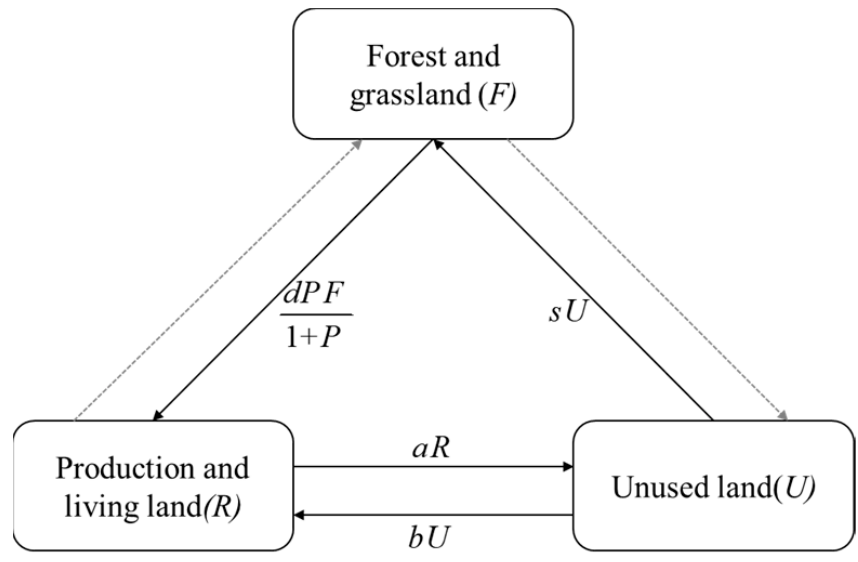
Figure 2. Evolution between different land-use types. Since the unit of land-use-type area is not consistent with that of the population,